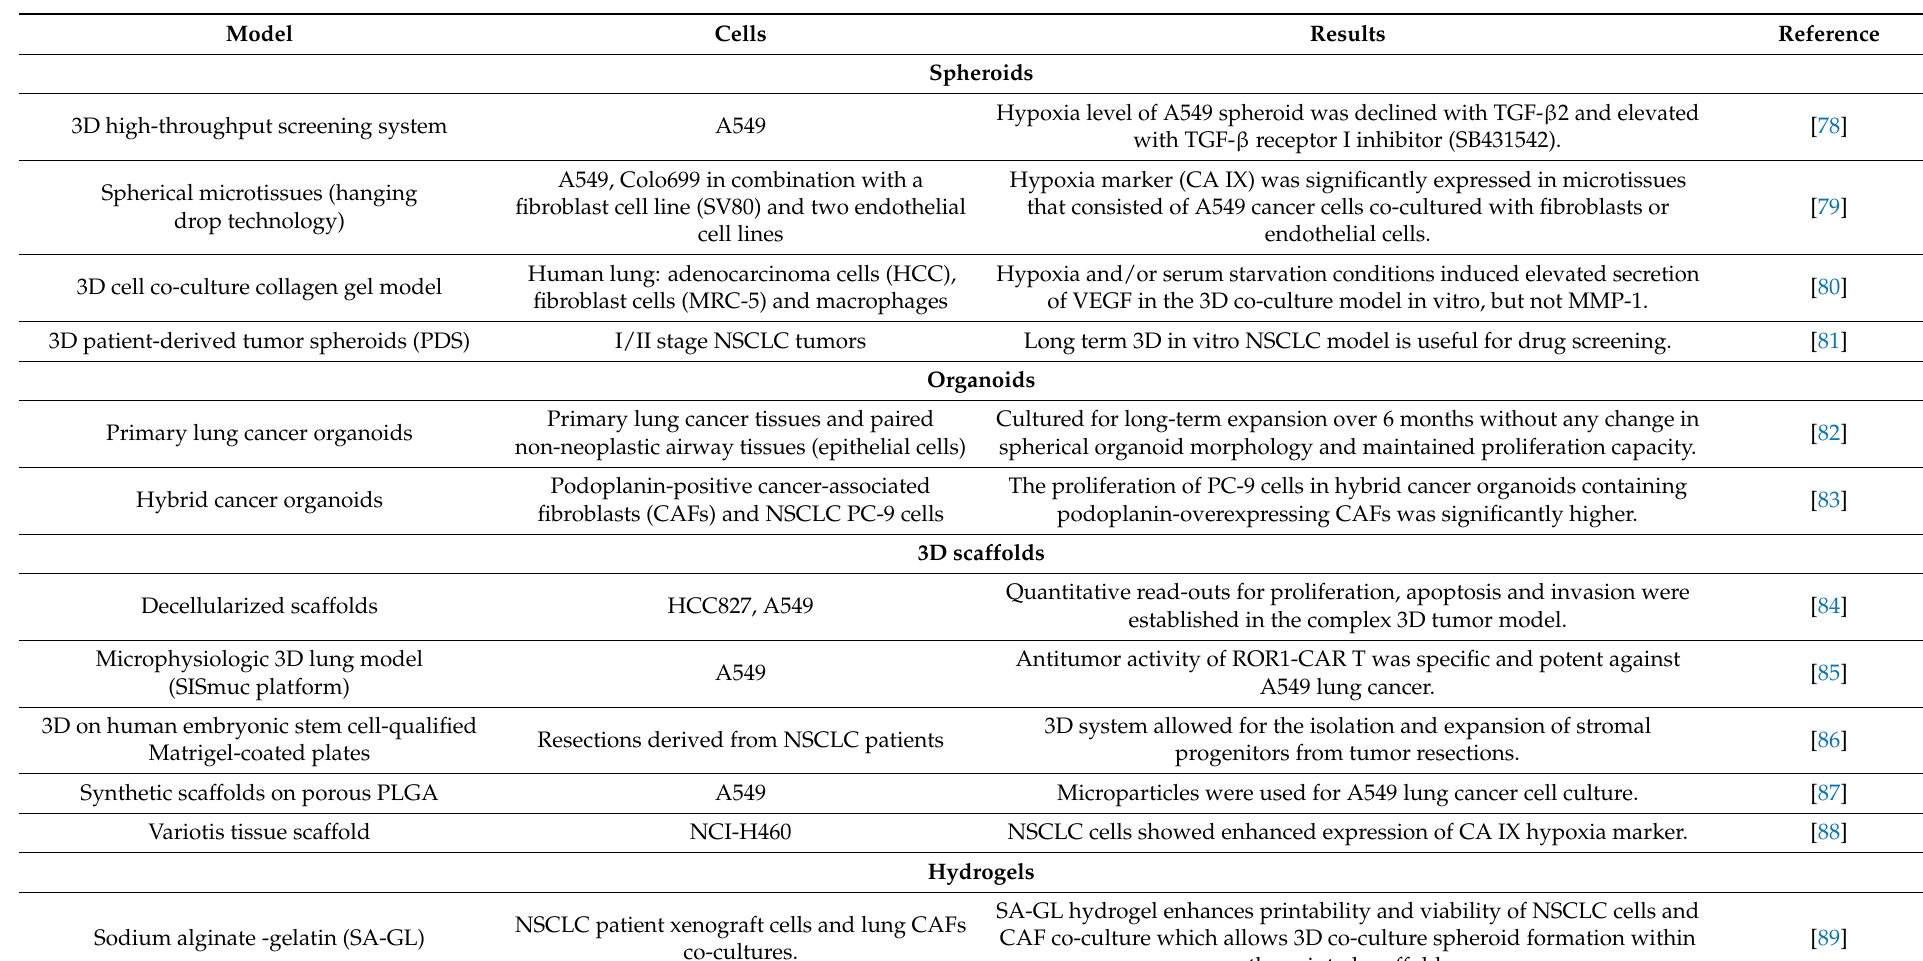
Table 2. Various types of 3D NSCLC in vitro models (spheroids, organoids, 3D scaffolds, hydrogels, microfluidics, 3D bioprinting) that have been employed to generate hypoxic microenvironment in